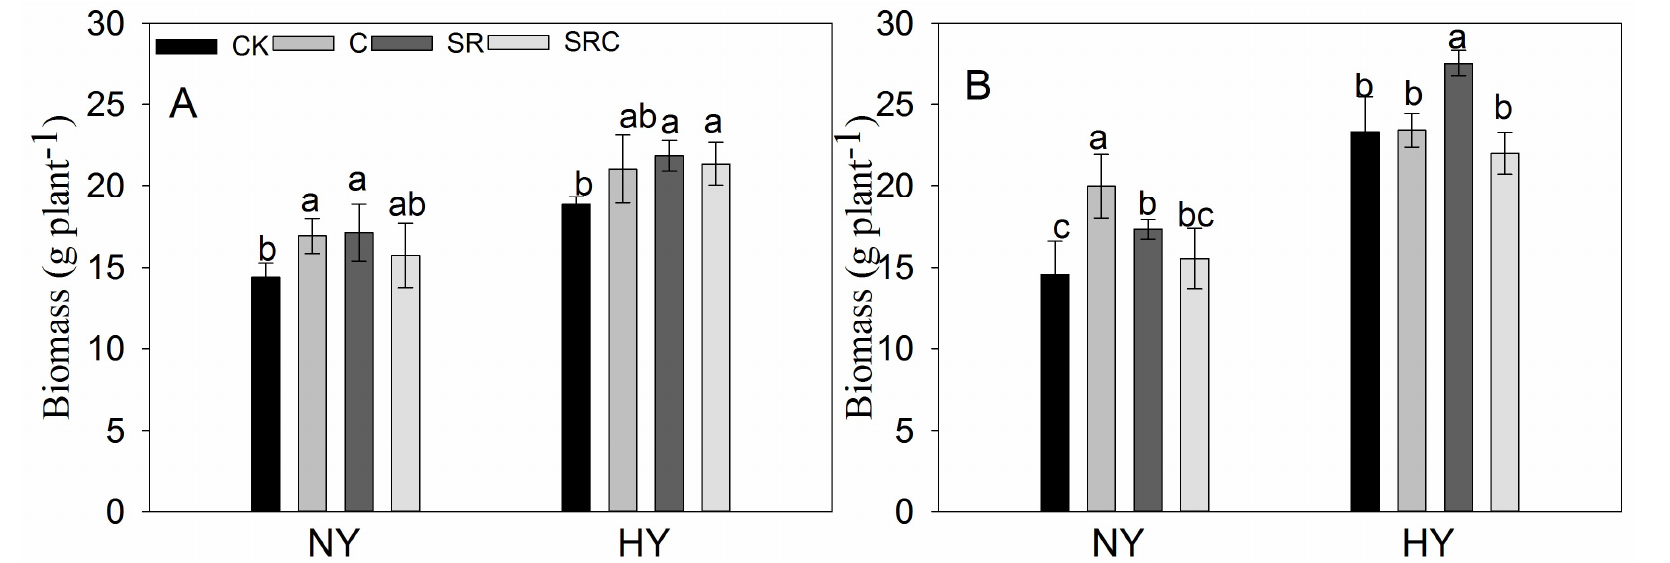
Figure 4. Effects of biochar and soft rock treatments on millet biomass at flowering under two fertilizer levels conducted in 2018 ( A ) and 2019 ( B ). CK, sand only; C, sand and biochar; SR, sand and soft rock; SRC, sand, biochar, and soft rock; NY, normal yield pattern; HY, high yield pattern. Data were shown in mean ± SE. Different letters indicate significant differences ( p < 0.05).